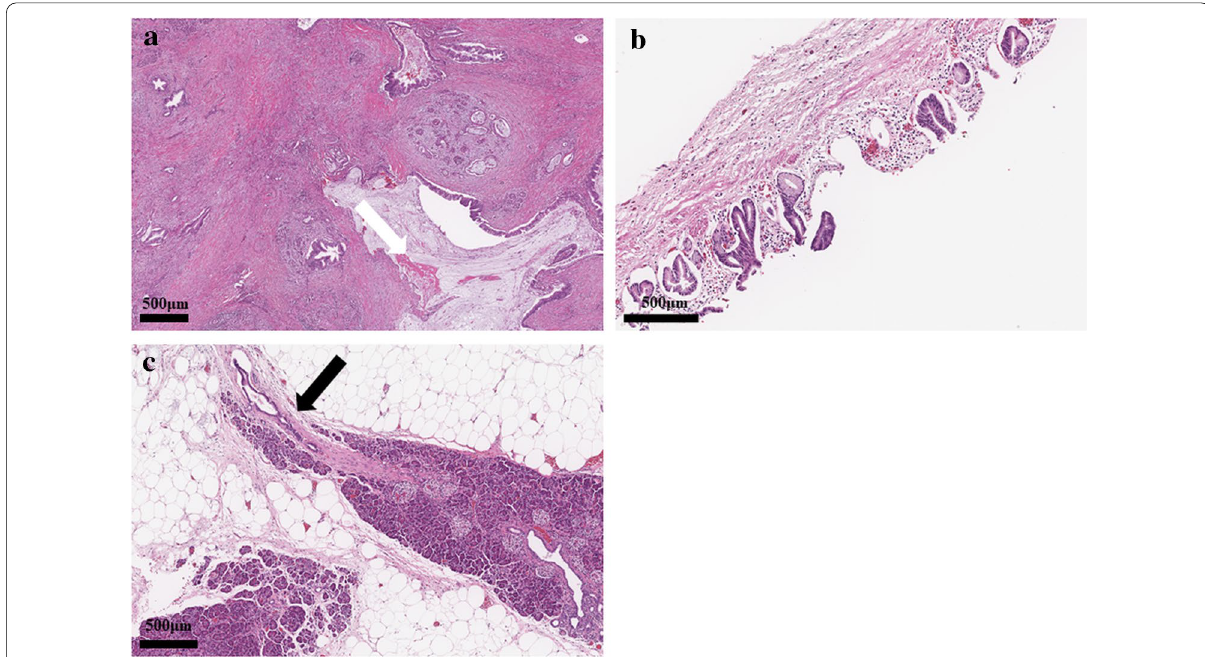
Fig. 5 Microscopic findings of resected specimens. a The tumor was composed of moderately differentiated invasive PDAC, and carcinoma in situ and high-grade pancreatic intraepithelial neoplasia surrounded the tumor (white arrow). b Glandular fossa epithelium and gastric fundic gland were observed on the luminal side of the GDC, and mucosal muscle plate and muscle layer were also observed. c The fistula between the GDC and pancreas was histopathologically observed (black